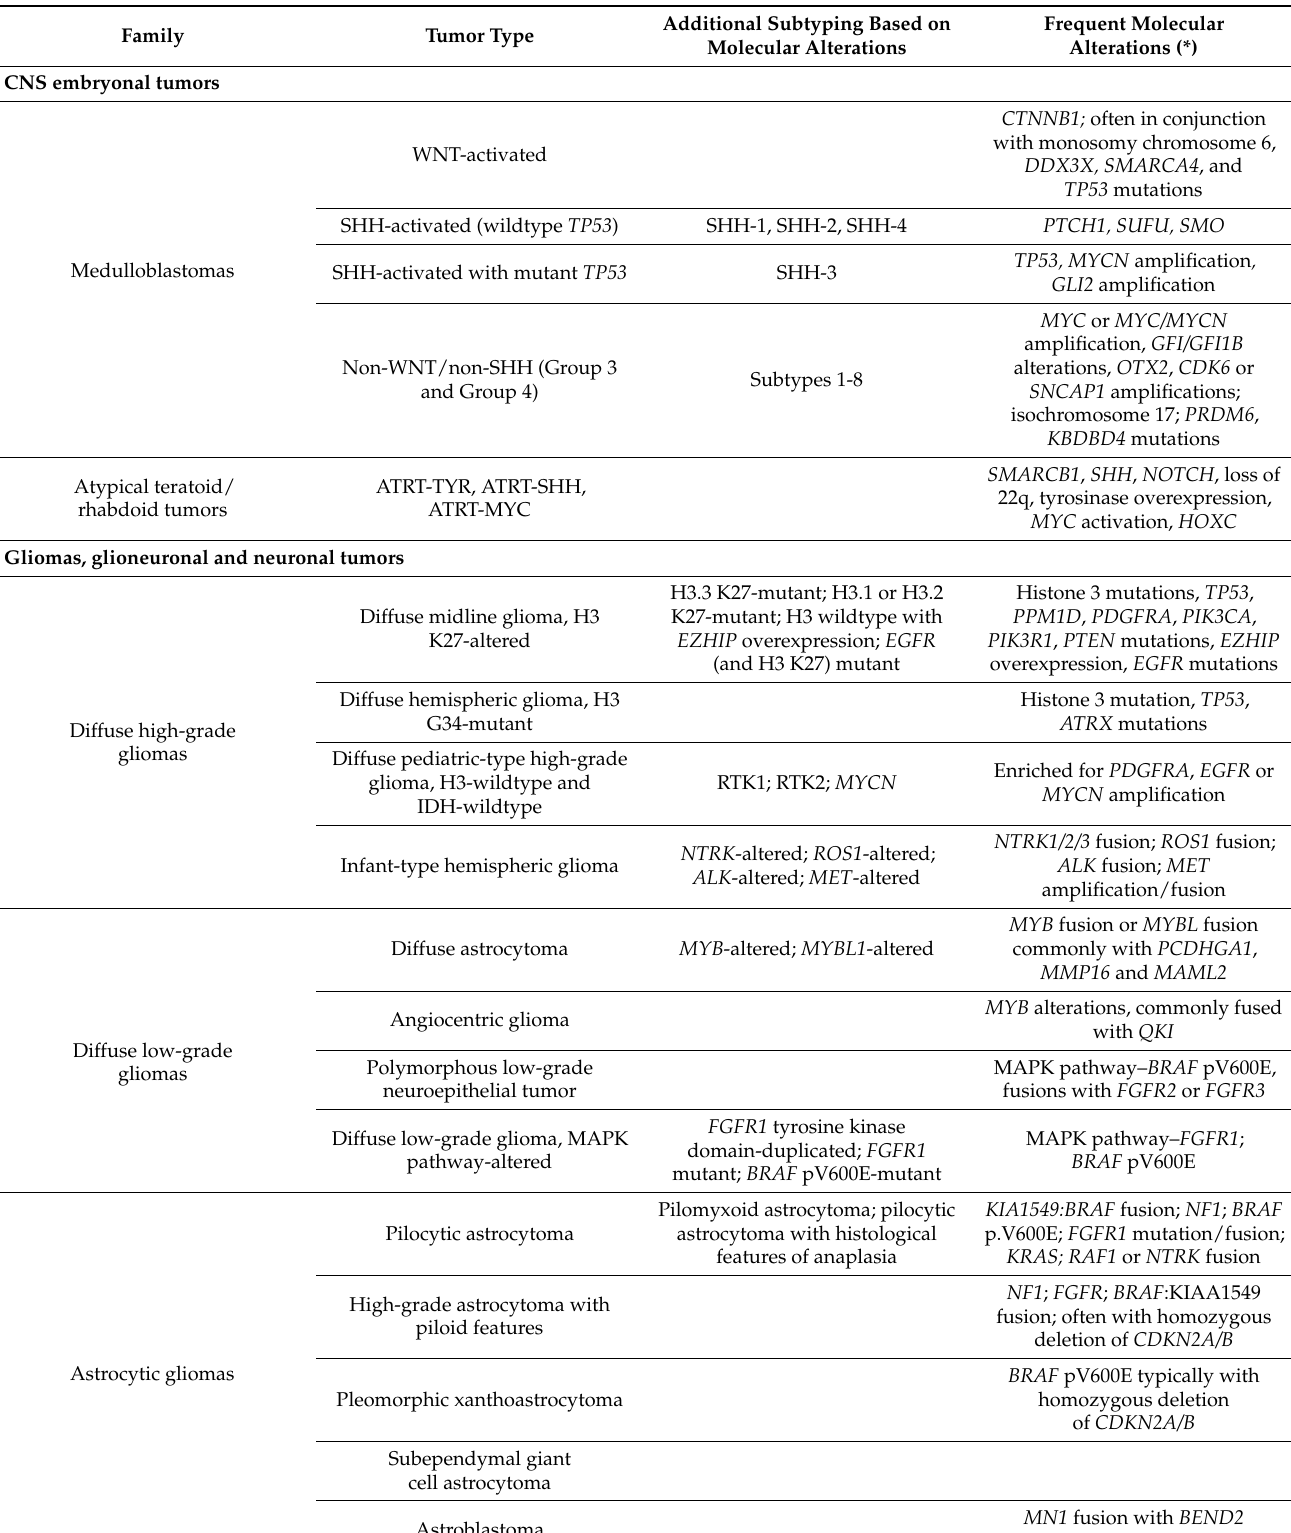
Table 1. Pediatric brain tumors—an